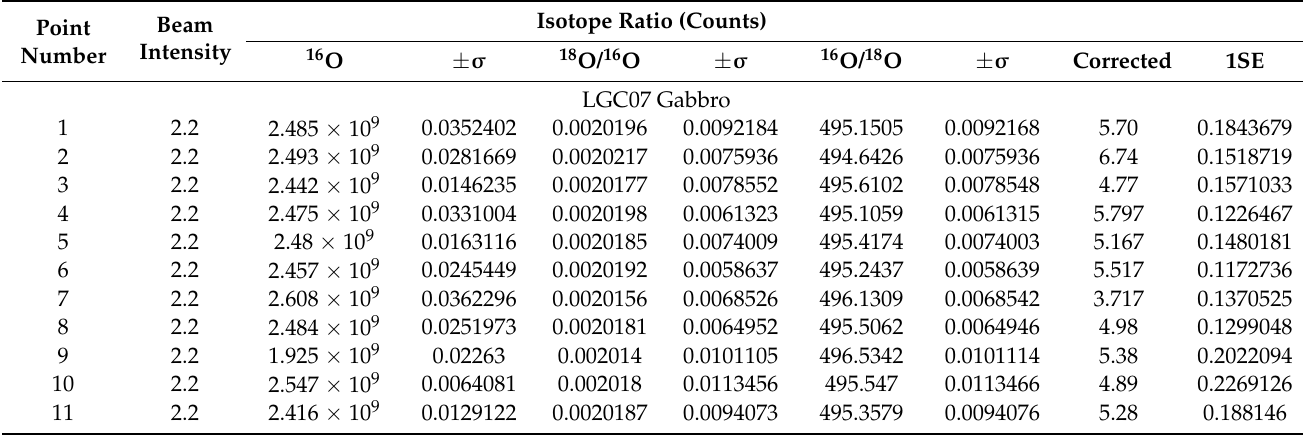
Table 3. SIMS zircon O data of gabbro, Laguoco,